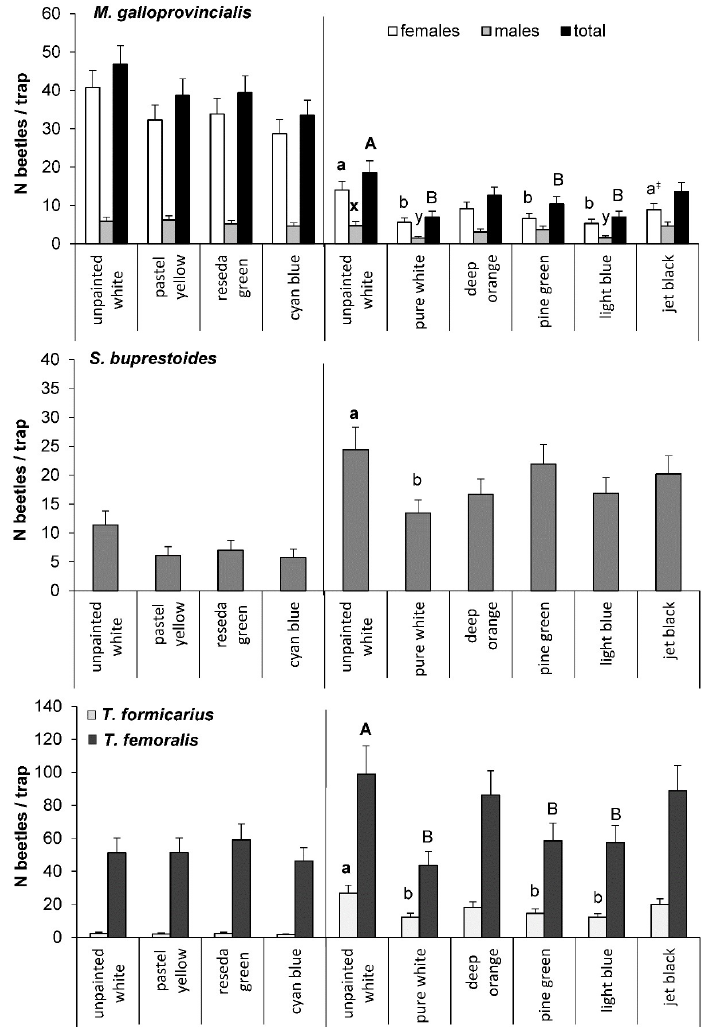
Figure 5. The number (estimated mean and SE) of beetles of M. galloprovincialis and three most abundant insect species captured in the traps of different colors: 2019, 24 June–9 July for M. galloprovinicialis , 24 June–1 July for other species (N = 14 traps/color); 2020, 29 June–29 July (N = 10 traps/color); different letters above bars indicate significant differences between the traps of different colors and the unpainted white (reference) traps within sex or species for each year separately at α = 0.05, ‡ the difference was nearly significant ( P = 0.0528). Raw numbers of captured beetles are provided in Supplementary Materials Table S2(a,b).